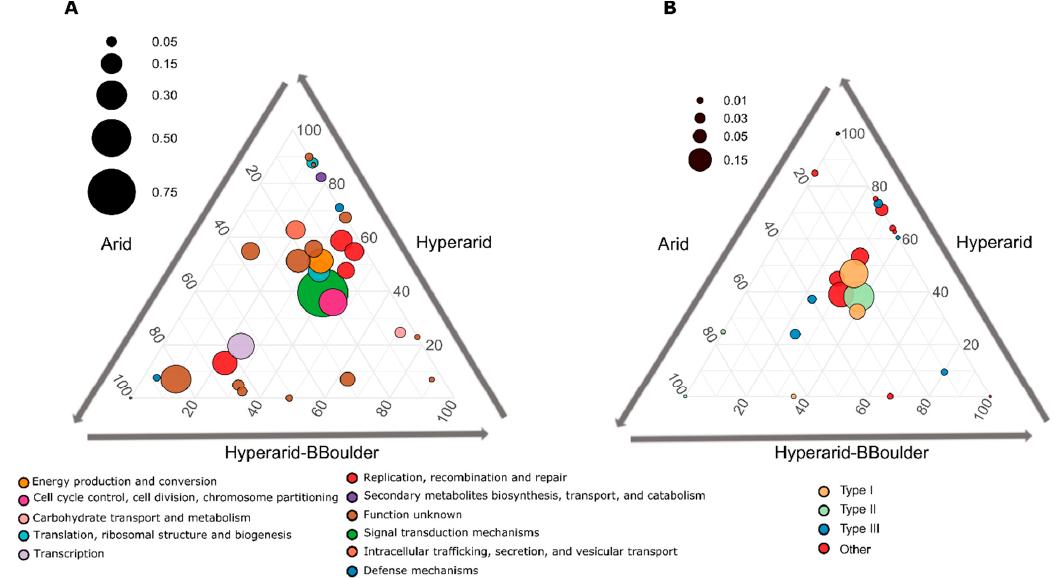
Figure 4. ( A ) Significantly enriched Cluster Orthologous groups (COGs) between the Hyperarid, Hyperarid-BBoulder and Arid sites co-occurring with MGEs in the microbial community of the Atacama Desert and ( B ) COGs associated with DNA restriction. n = 4, 5 and 3 at Arid, Hyperarid and Hyperarid-BBoulder sites, respectively. COGs with a p < 0.05 using DESeq2. The diameter of the circle represents the relative abundance of every COG on average co-occurring with MGEs. Number and lines indicate the contribution of every category to the dot position.